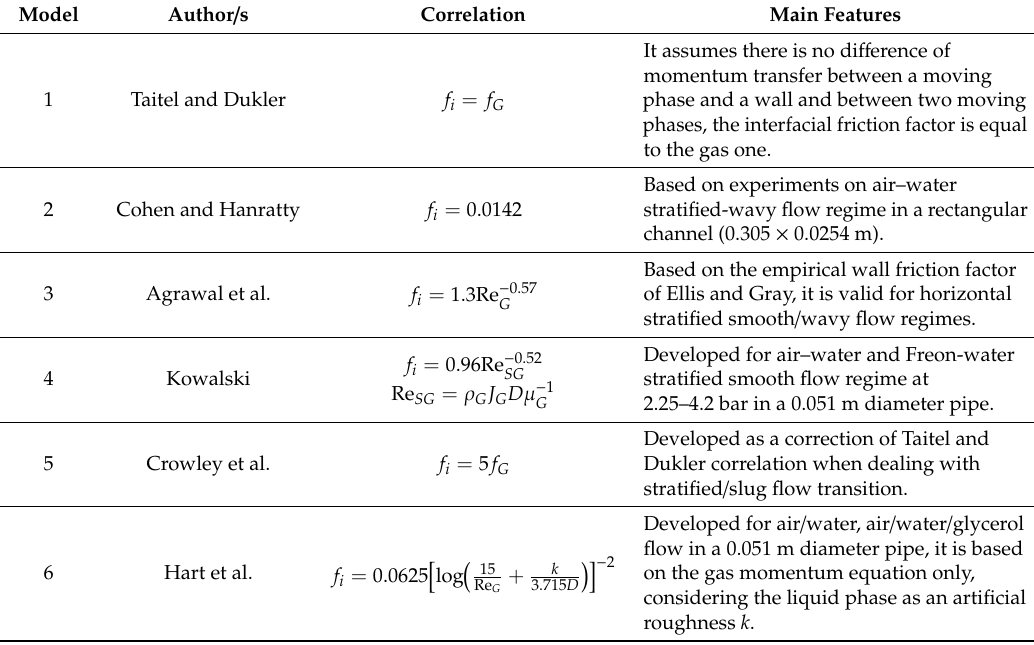
Table 5. Interfacial friction factor